Question: Which kind of chart has been used to present this data?
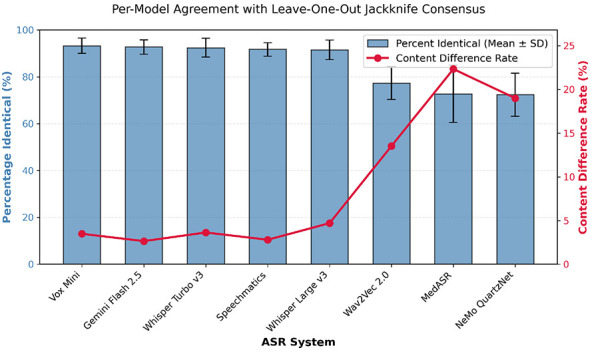
Answer: bar